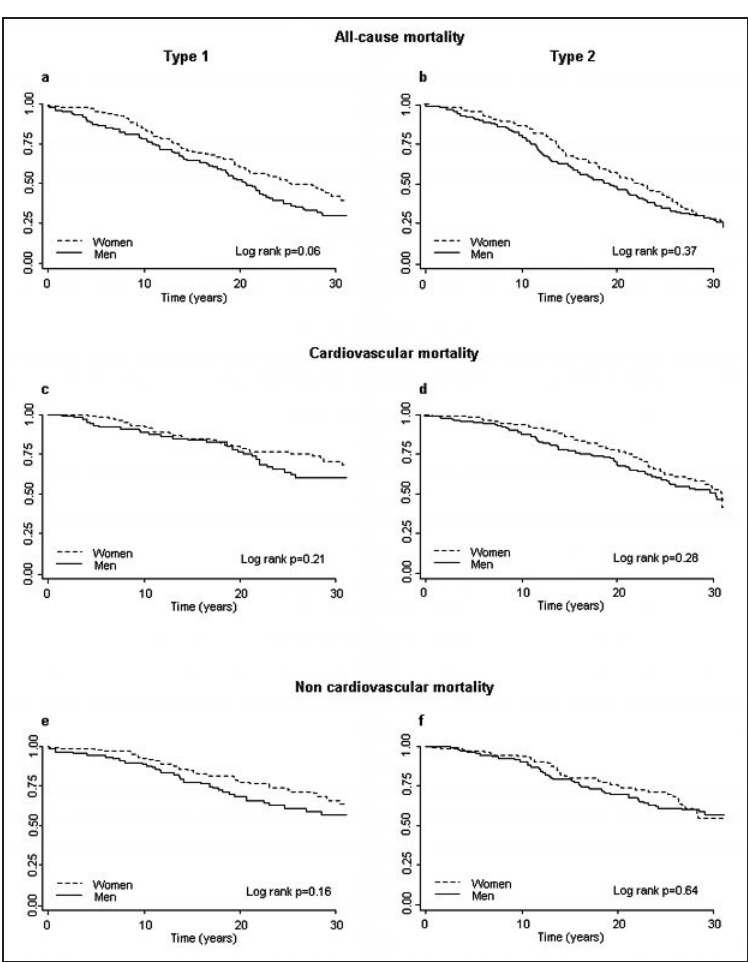
Figure 1 Kaplan-Meier estimation of survival probabilities according to type of diabetes and sex for all-cause mortality (Panels a and b), cardiovascular mortality (Panels c and d), and non-cardiovascular mortality (Panels e and